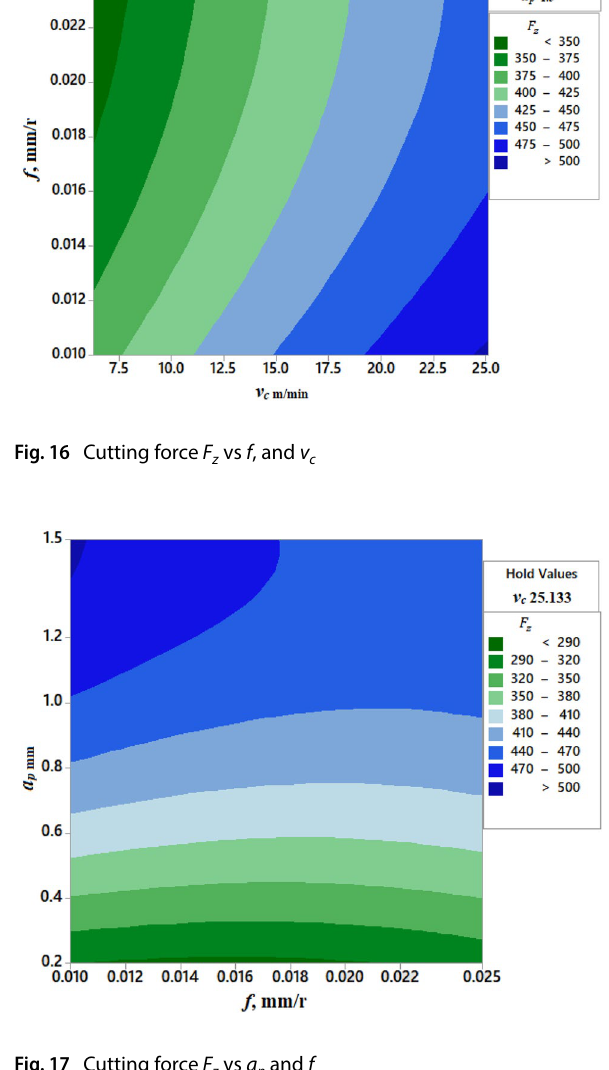
Fig. 17 Cutting force F z vs a